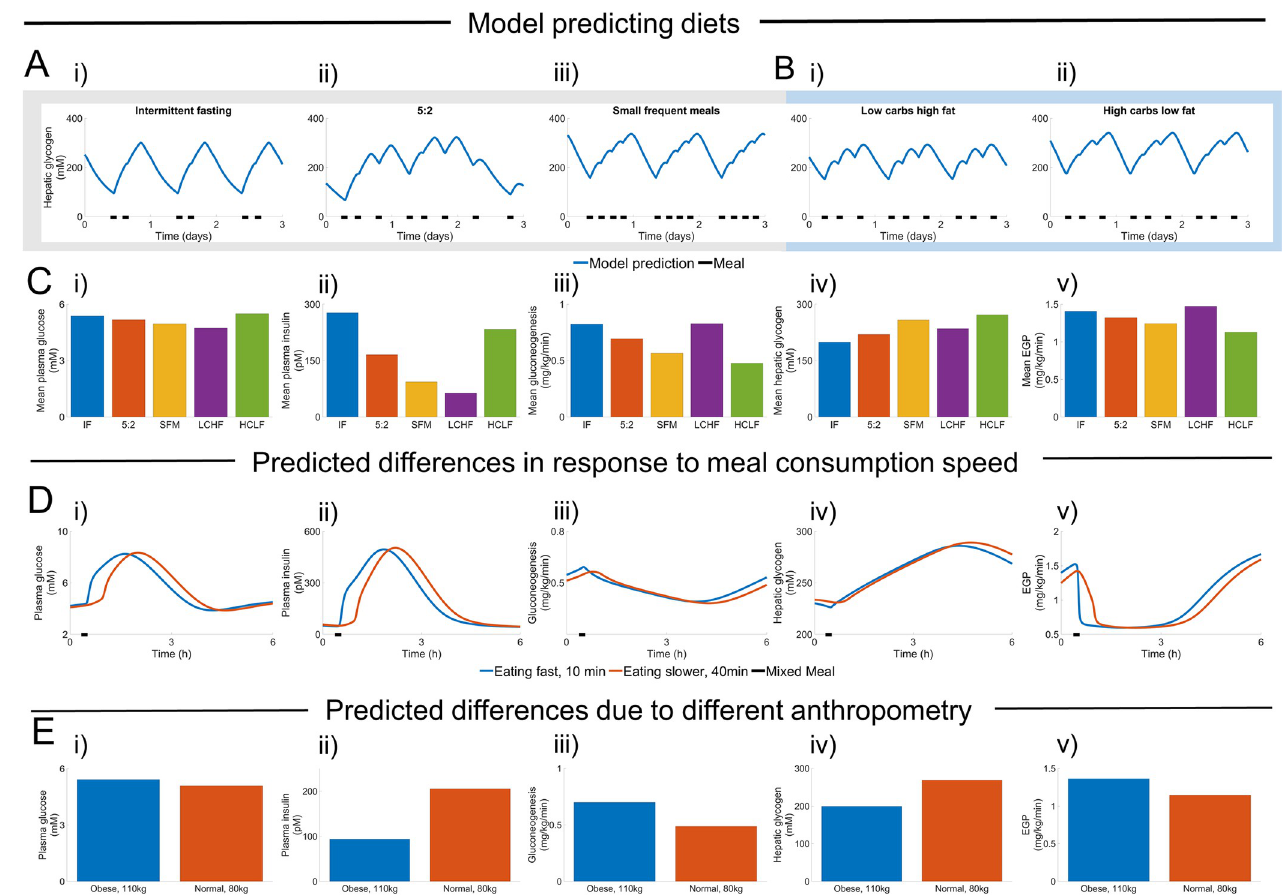
Fig 7. Simulations of five common diet schemes and varying different personalized variables. (A) The model considers diets with different meal frequencies, ranging from Intermediate Fasting (IF) with two meals (depicted as black bars), to 5:2 with 2–3 meals, and even SFM (with three smaller meals). These three diets are isocaloric. (B) The model can also to some extent simulate different compositions, such as LCHF (low carbohydrate, high fat diet), and HCLF (high carbohydrate, low fat diet). (C) Mean values of key variables during the second week after the diet has started. (D) Impact of changing the rate of consumption. E) Impact of changing the body weight by 30 kg, while keeping all other variables constant. All simulations in A-D were done using a male who was 180 cm, 80 kg, and in E that male either weighed 110 or 80